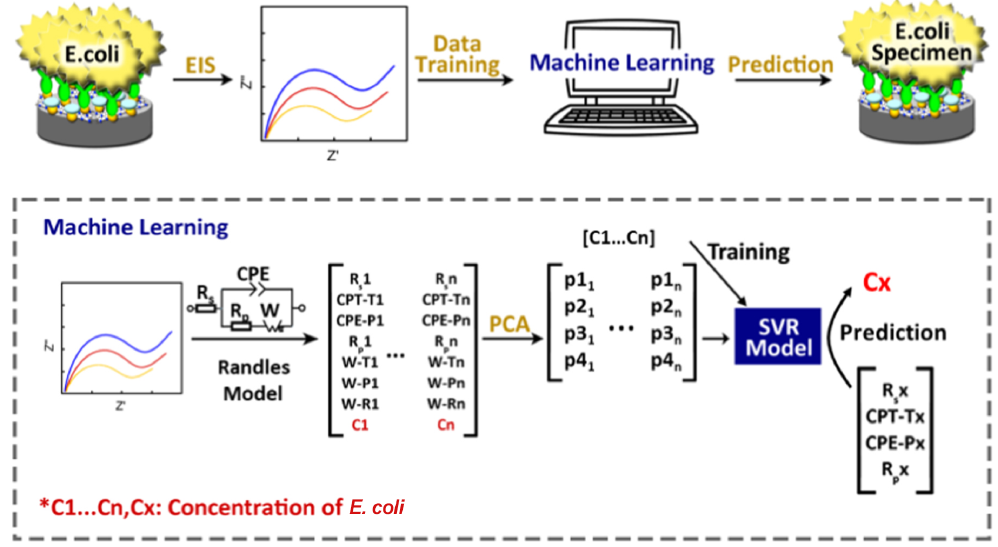
Figure 11. A graphic representation of how ML can work for EIS. Taken from [30] © The Electrochem- ical Society. Reproduced by permission of IOP Publishing Ltd. All rights